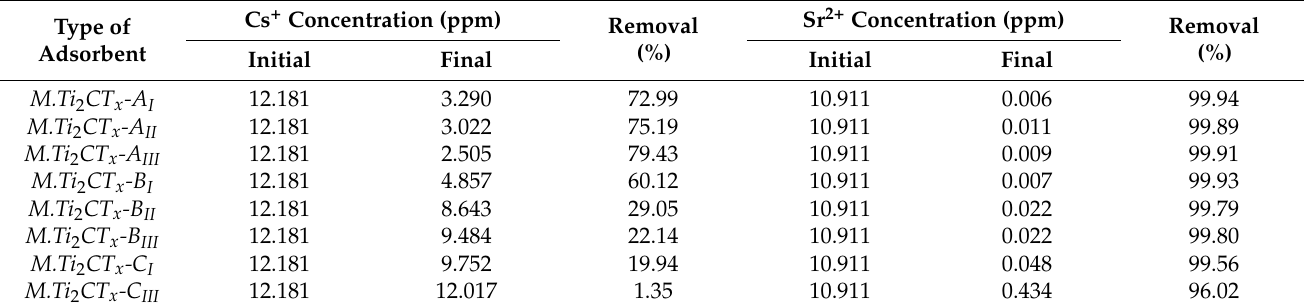
Table 2. Sr 2+ and Cs + removal by various M.Ti 2 CT x